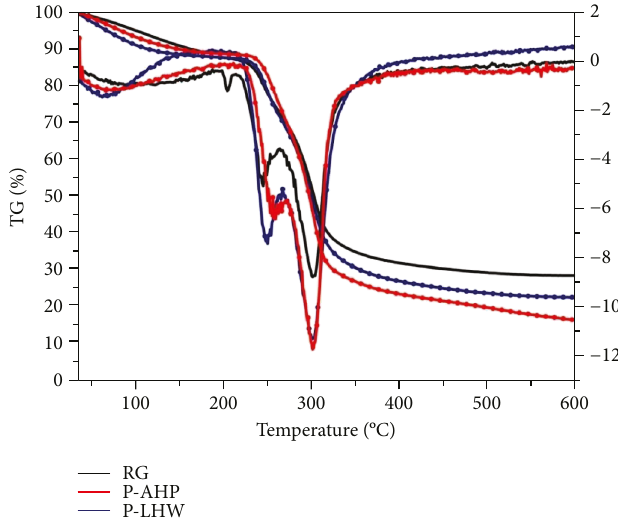
Figure 2: TG and DTG curves of the polysaccharide fractions.